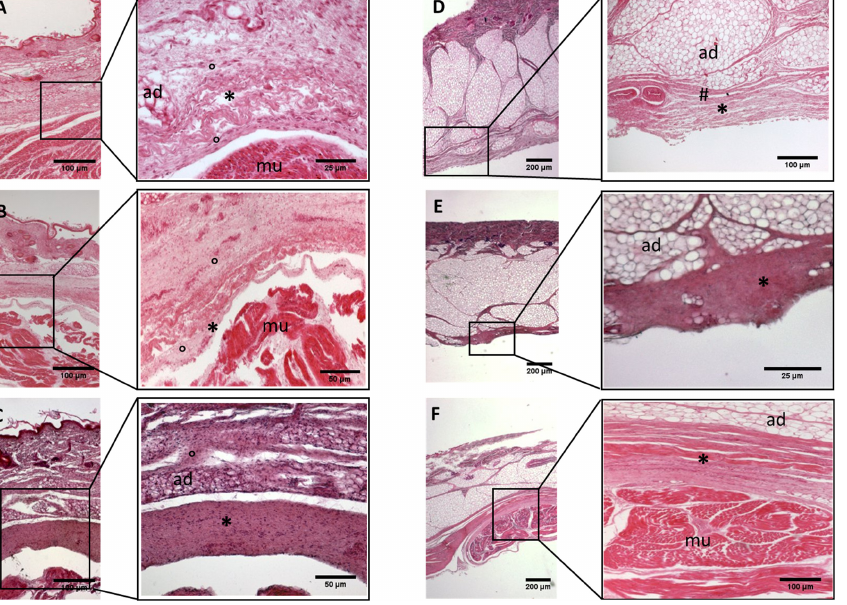
Figure 4 . Histological images (hematoxilyn-eosin) of lower limb, leg: crural fascia development . ( A ): 24 weeks; ( B ): 27 weeks; ( C ): 29 weeks; ( D ): 36 weeks; ( E ): 38 weeks; ( F ): 40 weeks. (*): deep fascia; (°): mesenchymal cells; (#): areolar tissue; (mu): muscle; (ad): adipose tissue. The first part of gestation is distinguished ( A – C ) by an irregular connective tissue without clear organization in layers, whilst the second part of the gestation ( D – F ) showed up with a denser connective tissue, and was better organized in the fascial layers.